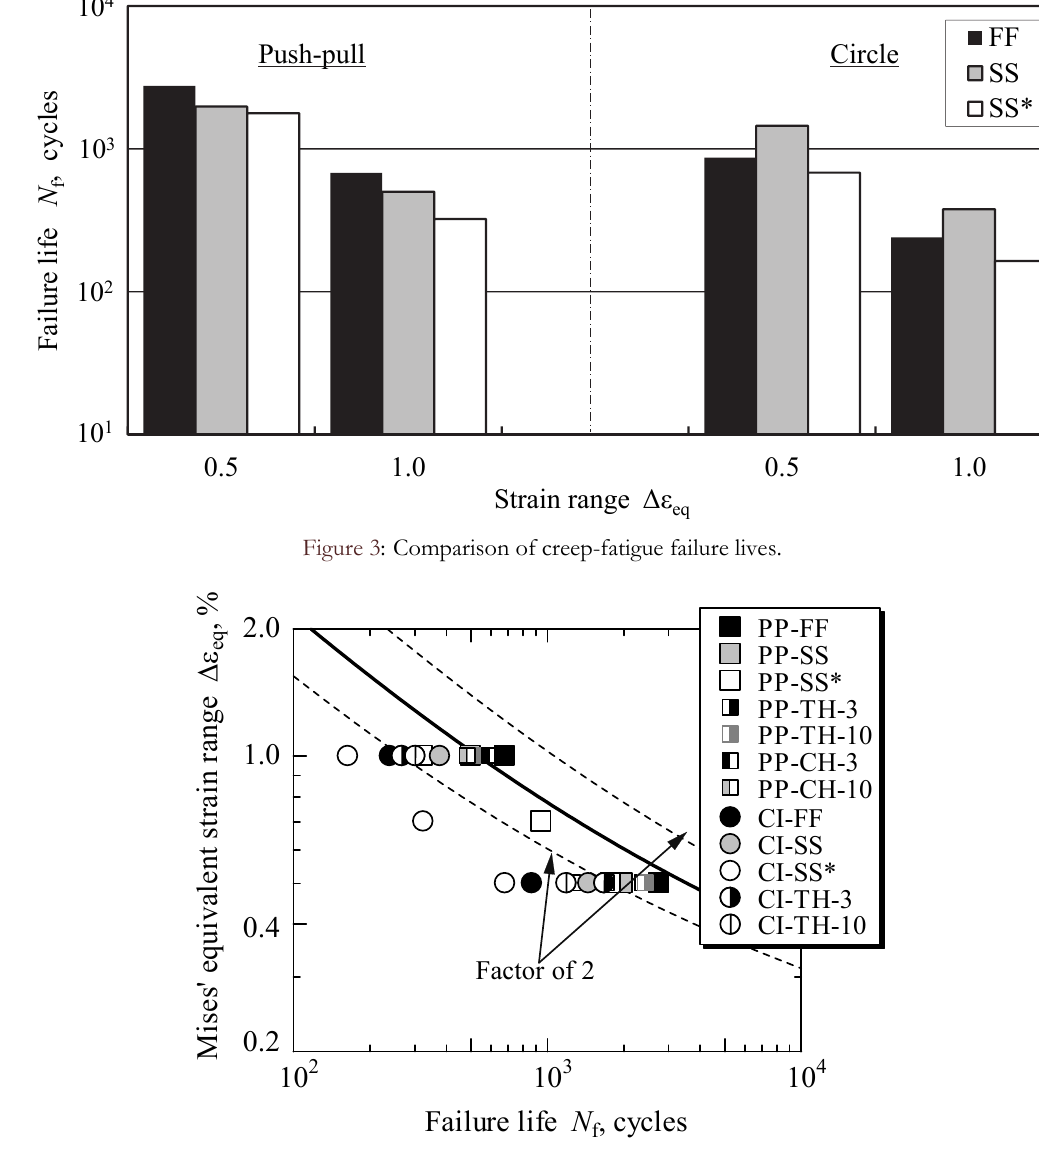
Figure 4: Correlation of N f by Mises’ equivalent strain